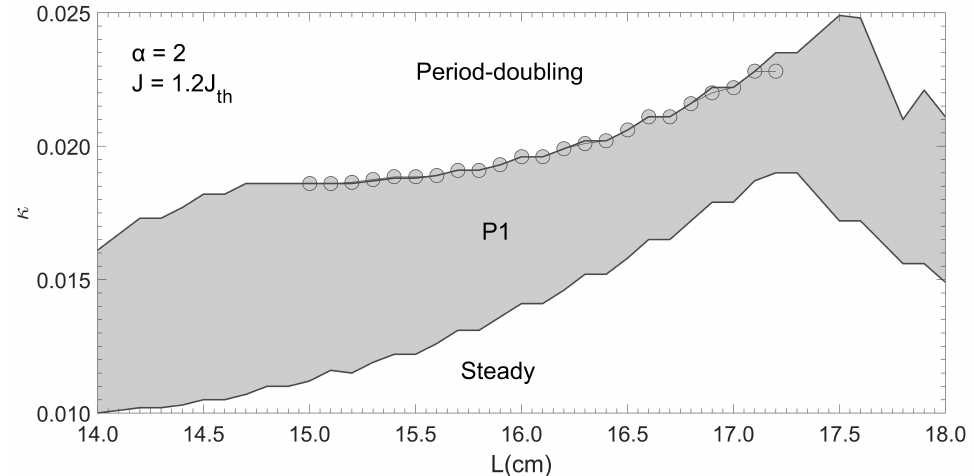
Figure 3. State diagram under the parameter space ( κ , L